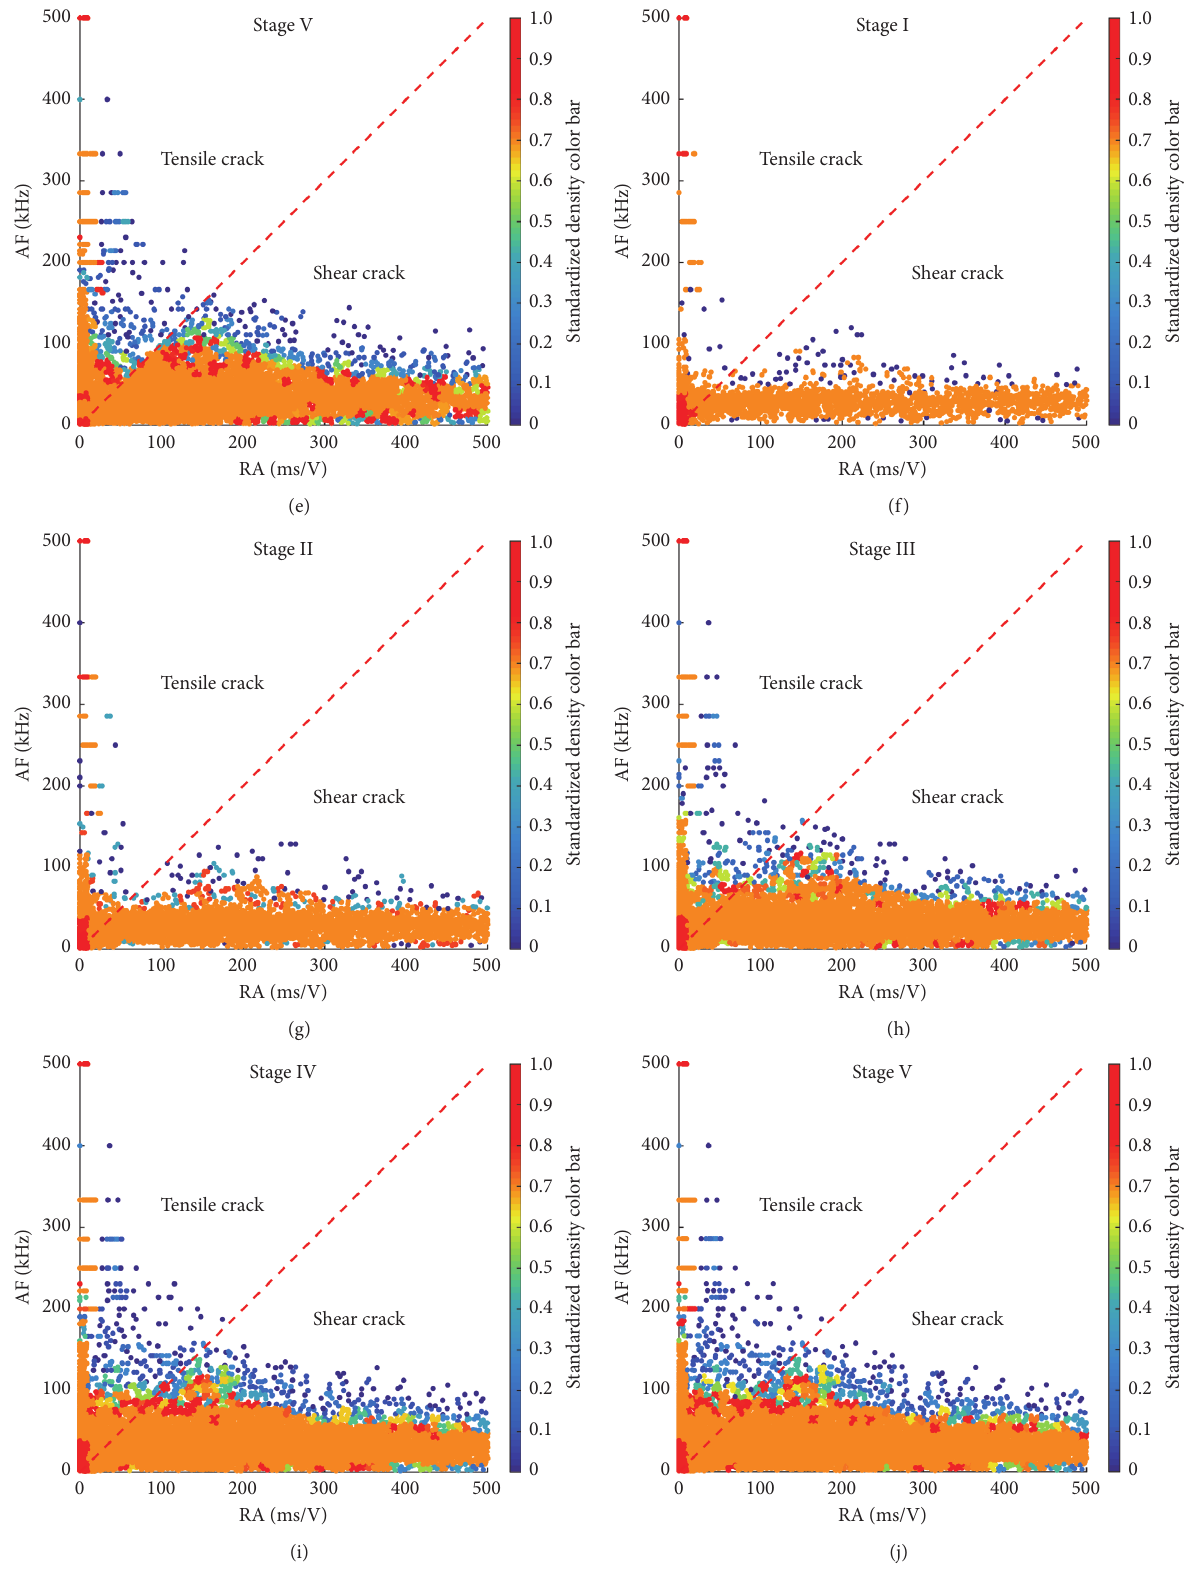
Figure 8: Evolution diagram of RA-AF scatter density distribution of sandstone under uniaxial compression: (a) Stage I of specimen UC-1. (b) Stage II of specimen UC-1. (c) Stage III of specimen UC-1. (d) Stage of specimen UC-1. (e) Stage V of specimen UC-1. (f) Stage I of specimen UC-3. (g) Stage II of specimen UC-3. (h) Stage III of specimen UC-3. (i) Stage IV of specimen UC-3. (j) Stage V of specimen